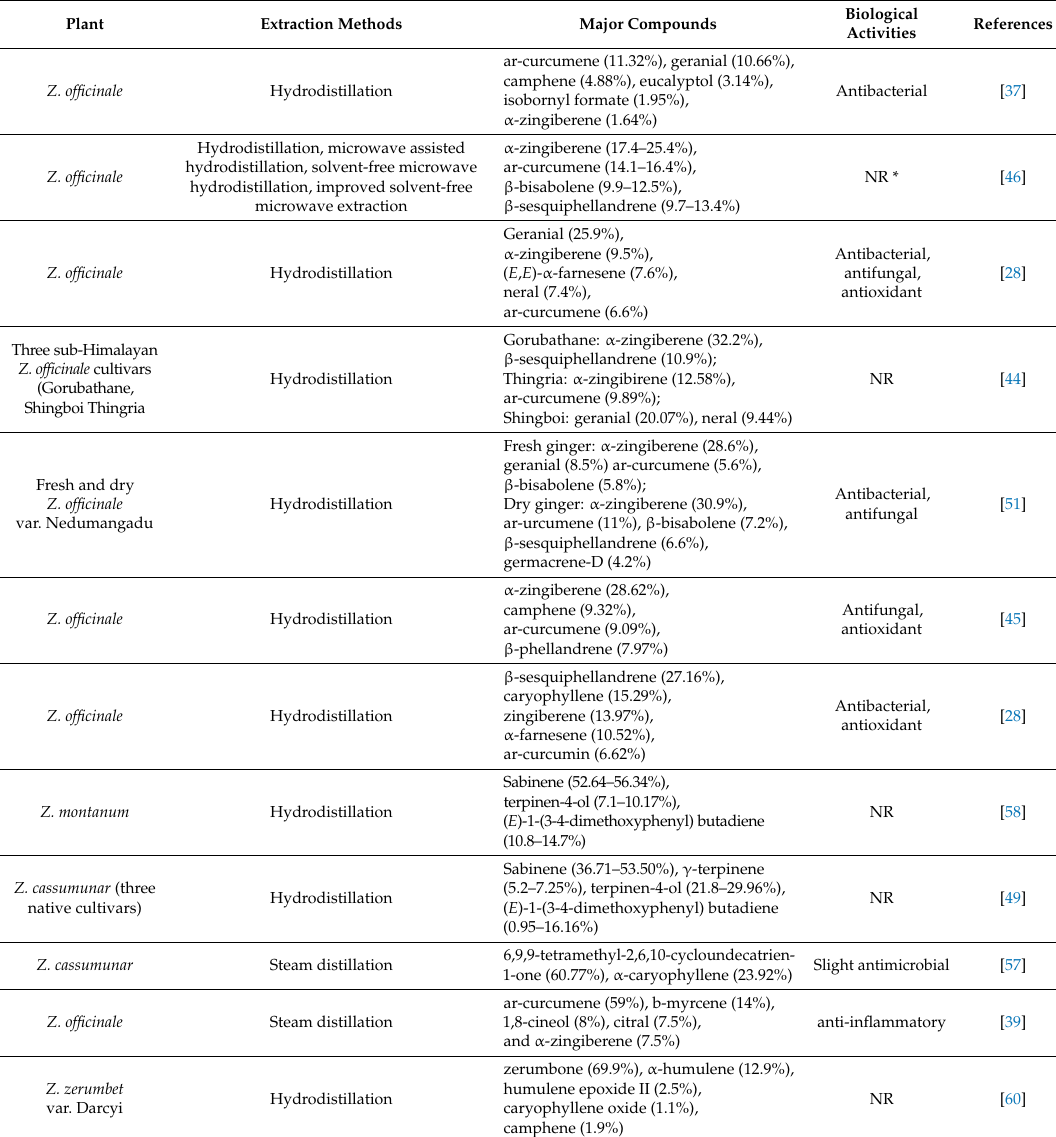
Table 1. Extraction methods, major constituents and biological activities of Zingiber spp. essential